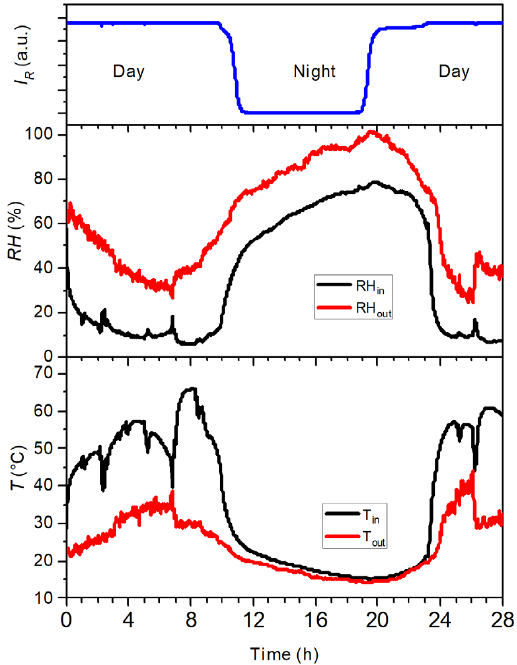
Figure 7. Data acquired by our sensors: periods of day and night, relative humidity and temperature variation over time.